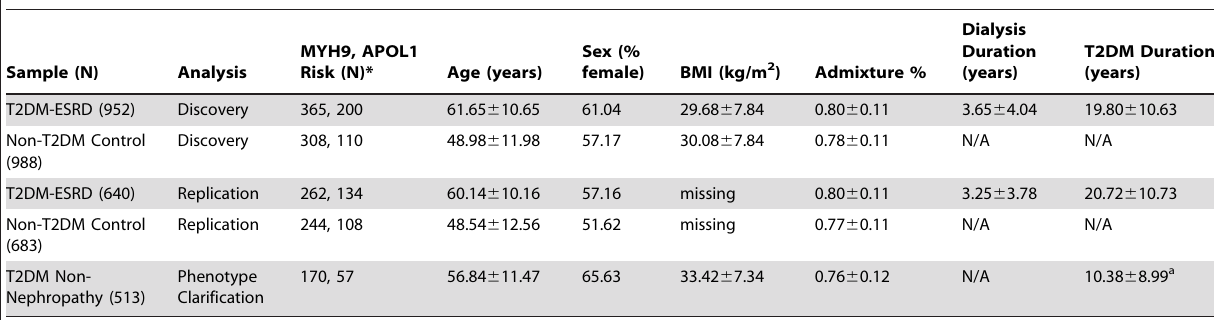
Table 1. Demographic characteristics of study groups.